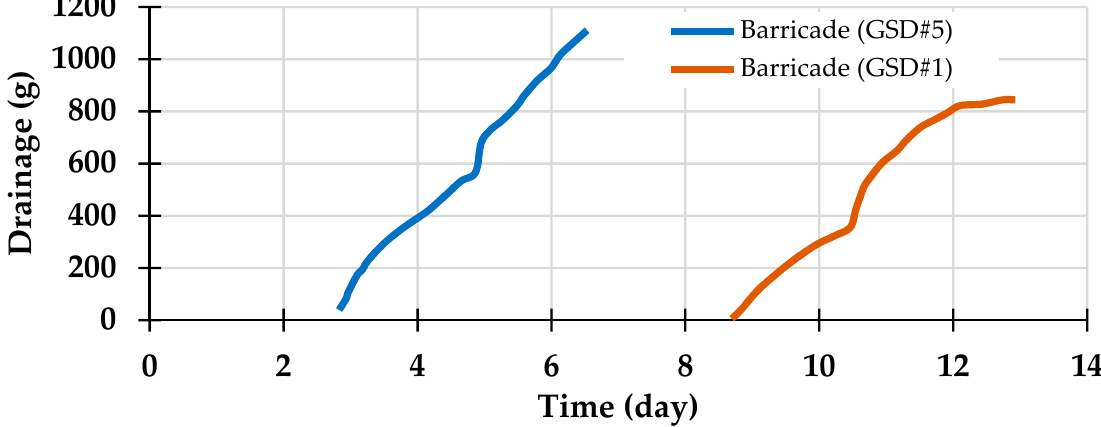
Figure 10. The drainage water collected during the tests.